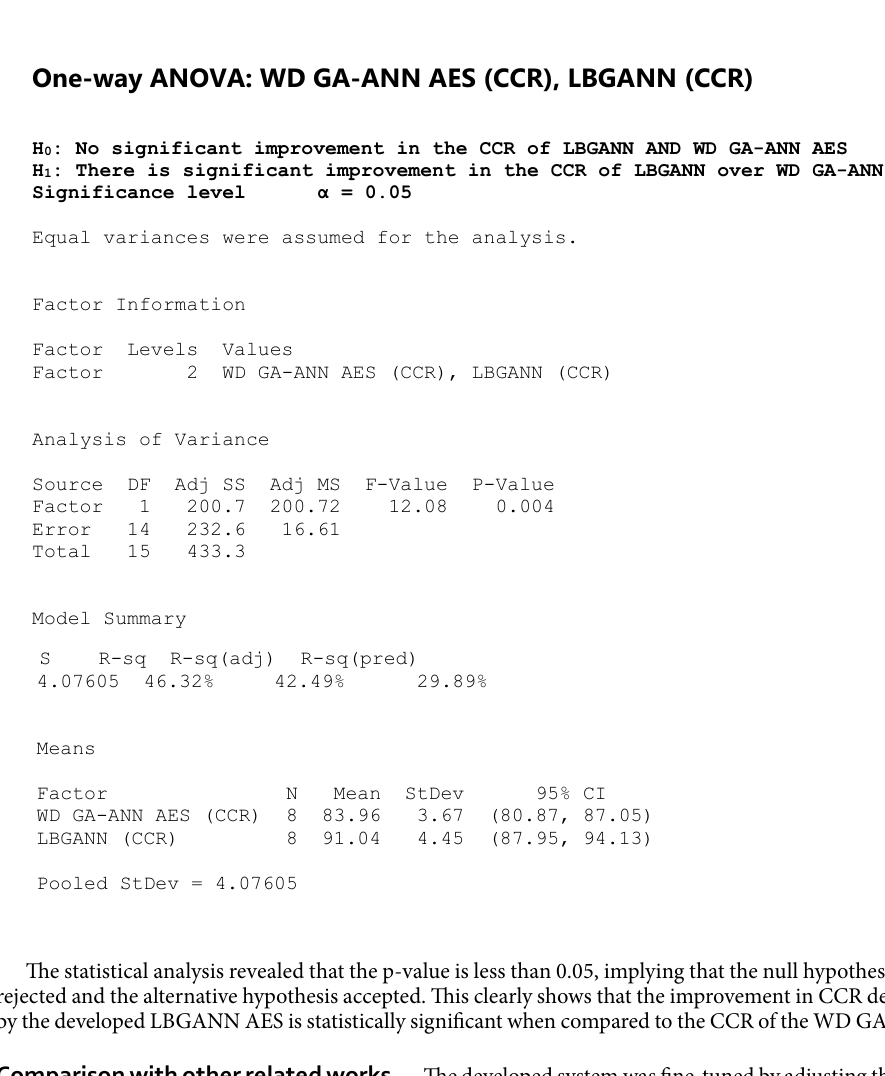
Figure 14. CCR for LBGANN and WD GA-ANN